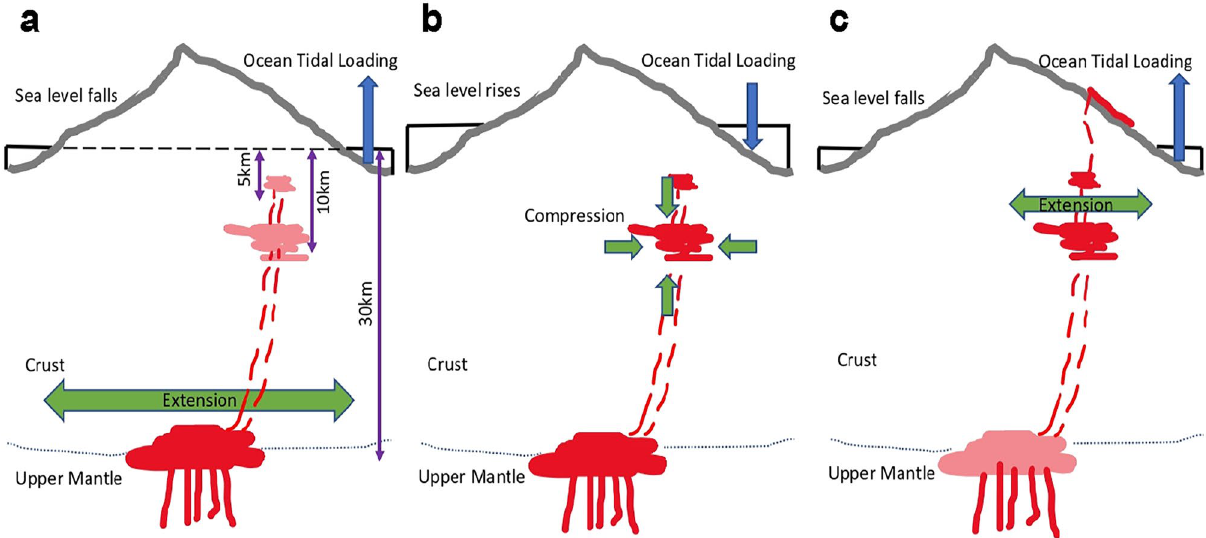
Figure 4. Schematics of the proposed sequence of magmatic activity related to the observed correlations between tides and earthquakes. Although extension and compression alternate on a daily basis, seismicity in phases 0 and 2 is favoured by extension, whereas in phase 1 compression is dominant. ( a ) Time period 2017- 10-07 to 2021-09-10 ( Phase 0 ). At low tides, sea level falls and ocean loading diminish, which means relative compression decreases and extension increases. High values of extensional tidal confining stress rates may facilitate a relative increase in magma upwards flow and encourage increased seismicity. The earthquakes occurred during this period opened new paths in the magma ascent (red dashed lines) from the deep reservoir at 25–30 km to a shallower one at 10 km, and to an even shallower reservoir around ~1–5 km depth, which filled shortly before the eruption. ( b ) Time period 2021-09-11 to 2021-09-19 ( Phase 1 ). Lateral growth of the reservoir at 10 km depth has ended, and conditions in this reservoir are more sensitive to small changes in the compressional tidal confining stress rates, until the beginning of the eruption on September 19. At high tides, sea level rises and ocean loading increases, promoting magma pressure build-up. Tidal confining stress rate compression, together with magmatic stresses, would over-pressurize this reservoir, causing potential failure and withdrawal through zones of weakness to ascend and favour seismic activity. ( c ) Time period 2021-09-20 to 2021-11-01 ( Phase 2–Set 2A ). After the start of the eruption on September 19, 2021, pressure within the magma reservoirs at 10 and 2–5 km depth drops, and seismicity is promoted by maximum values of extensional tidal confining